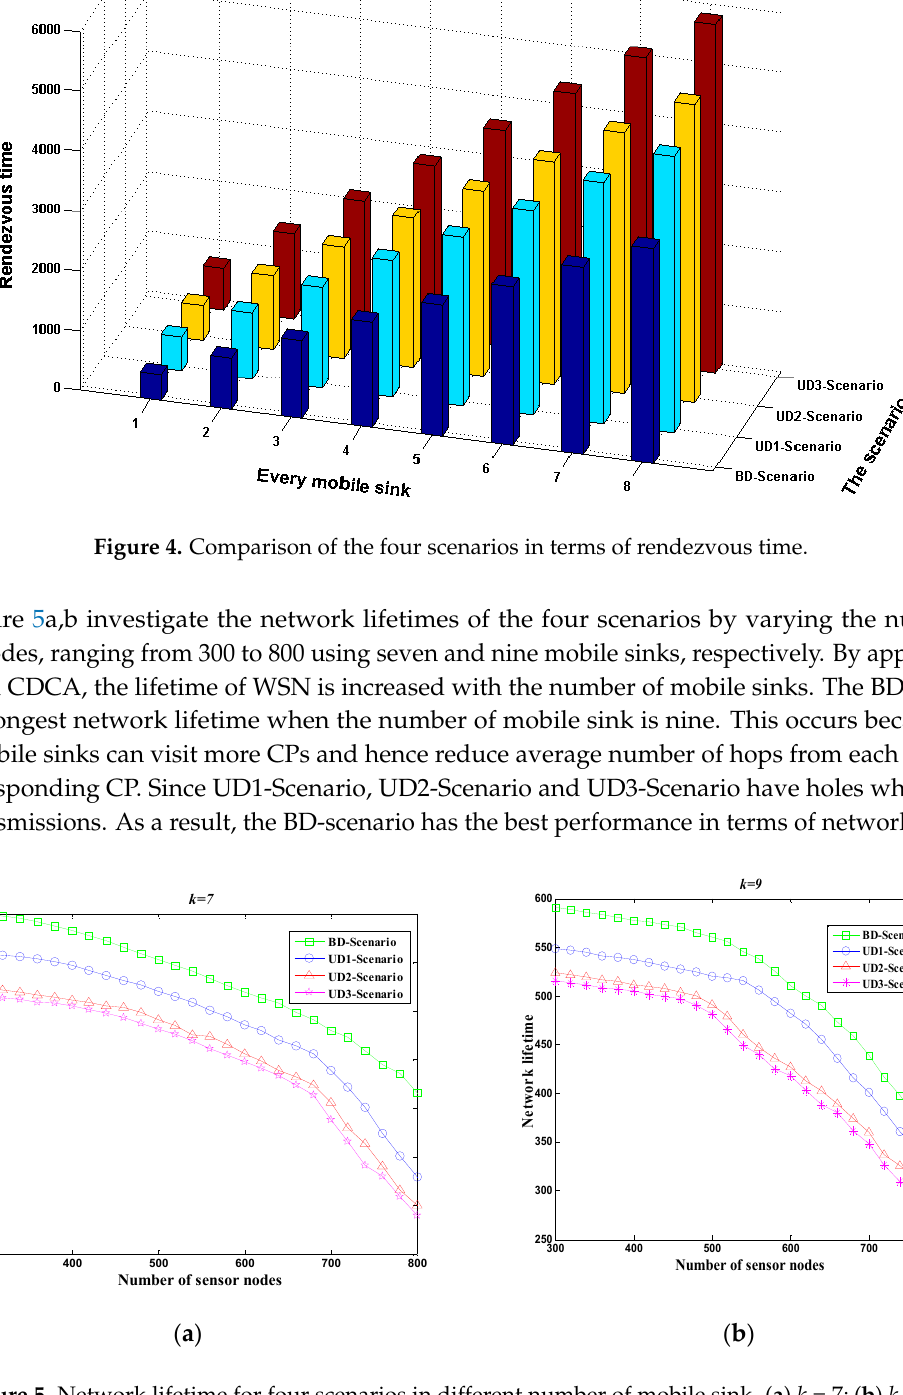
( d ) Figure 3. Four scenarios considered in the experiments. ( a ) BD-Scenario; ( b ) UD1-Scenario; ( c ) UD2- Scenario; ( d ) UD3-Scenario. Figure 4 shows the rendezvous time points between each of the eight local mobile sinks and the global mobile sink in four scenarios. In Figure 4, the four scenarios show the similar trend that the performance of BD Scenario is best and the rendezvous times are increased with the number of mobile sinks. In average, the BD Scenario saves 57% time cost, as compared with UD3-Scenario. Moreover, the UD2-Scenario and UD1-Scenario save 18% and 23% time costs, respectively, as compared with UD3-Scenario. The main reason is that BD Scenario has balanced deployment of sensors and contains no hole which might cause mobile sink moving from one side to another without any data collection operation, only for the purpose of travelling. As a result, the BD Scenario leads to a shorter path length. For each group, the proposed CDCA selects more CPs and creates